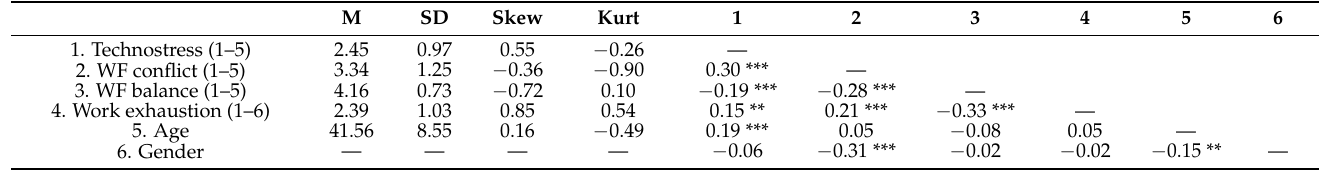
Table 1. Correlations between variables scores and control